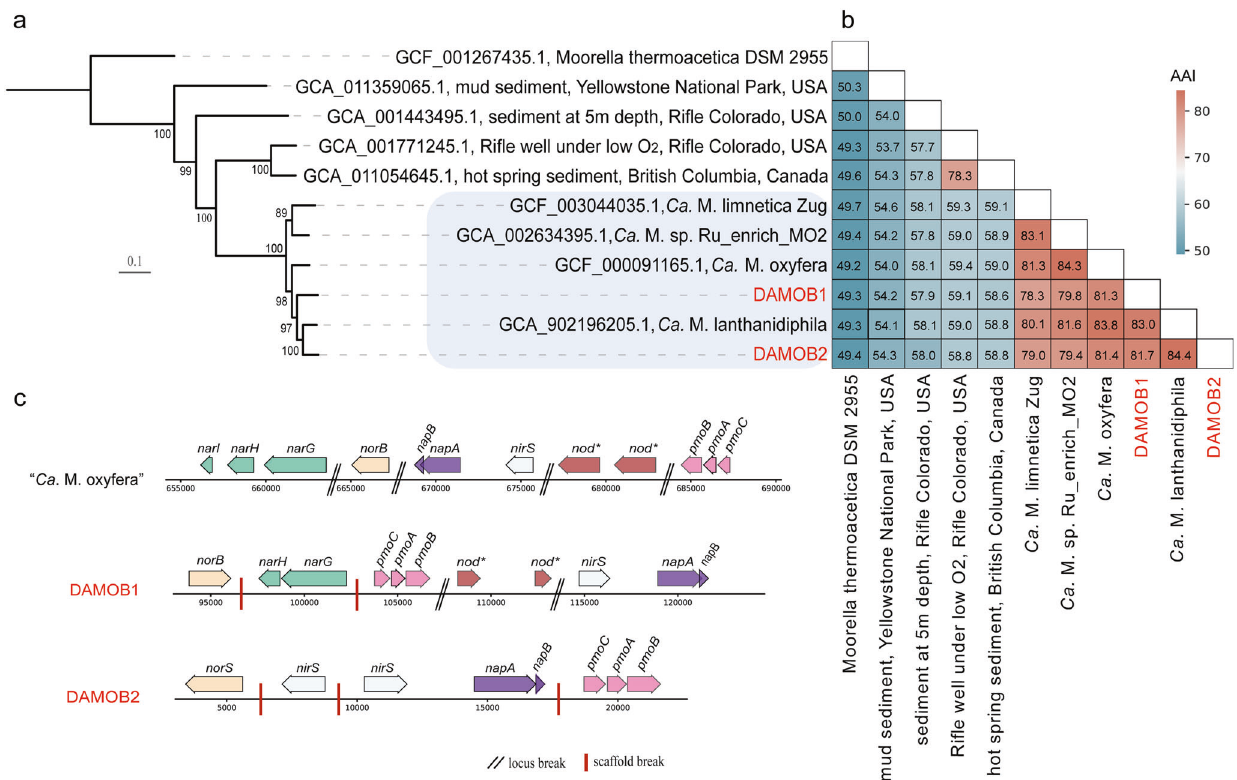
Fig. 2 Phylogenetic and genomic features of n-DAMO bacteria. a Phylogenetic placement of the two n-DAMO bacteria MAGs recovered in this study (DAMOB1 and DAMOB2) using 120 bacterial-speci fi c marker genes with publicly available non-redundant candidate division Methylomirabilota genomes (see method for details). The tree was inferred using the maximum-likelihood method, and bootstrap values were calculated using nonparametric bootstrapping with 100 replicates. The scale bar represents amino acid substitutions per site. The shaded area is clade a of Methylomirabilota phylum. b Average amino acid identity (AAI) as indicated by the values in cells. c Schematic representation showing the arrangement of genes for denitri fi cation and methane oxidation in two recovered genomes of n-DAMO bacteria in the present study and “ Ca . M. oxyfera ” (GCF_000091165.1). Arrows represent genes and indicate the transcriptional